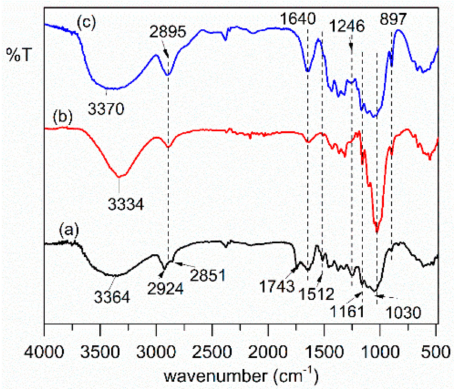
Figure 1. Fourier transform infrared spectroscopy (FT-IR) of ( a ) raw sugarcane bagasse (SB) and extracted cellulose from SB: ( b ) cellulose extracted from bleaching with 2% H 2 O 2 (CE-2), ( c ) cellulose extracted from bleaching with 5% H 2 O 2 (CE-1).